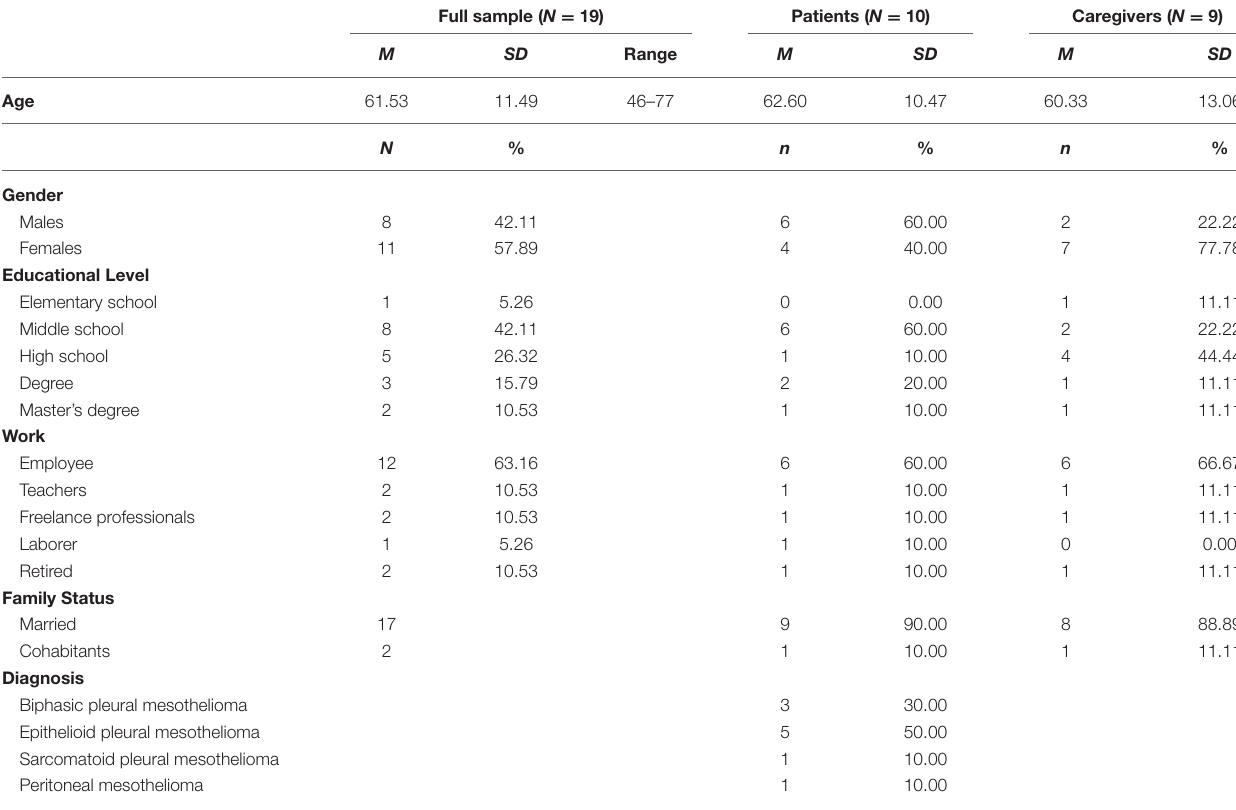
TABLE 1 | Socio-demographic and clinical characteristics of the sample.